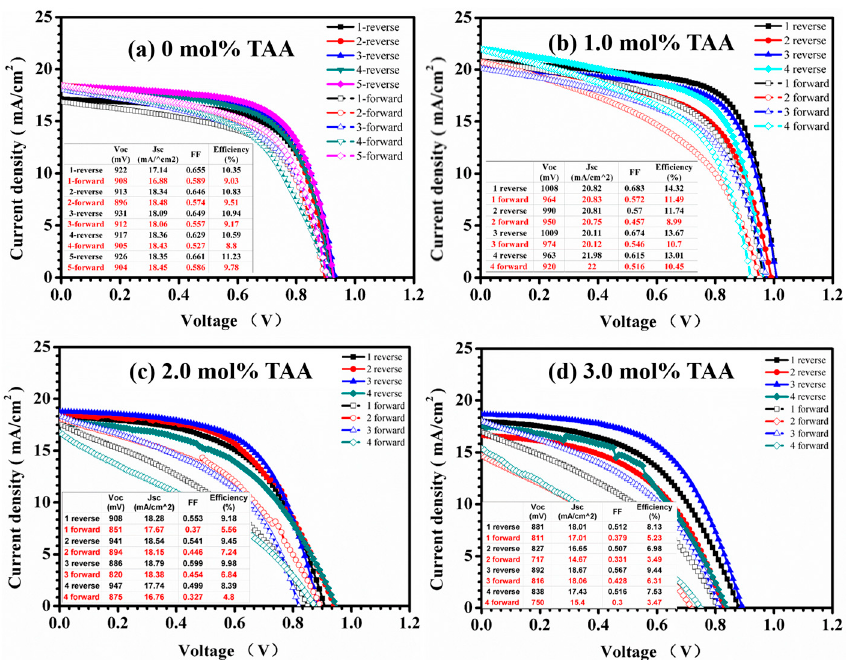
Figure 5. J-V characteristics of the gas-assisted processed PSCs based on TiO 2 compact layer deposited by the ultrasonic spray-coating of TiO 2 solution with the addition of TAA ( a ) 0 mol %; ( b ) 1.0 mol %; ( c ) 2.0 mol %; ( d ) 3.0 mol % with respect to the TiO 2 content.